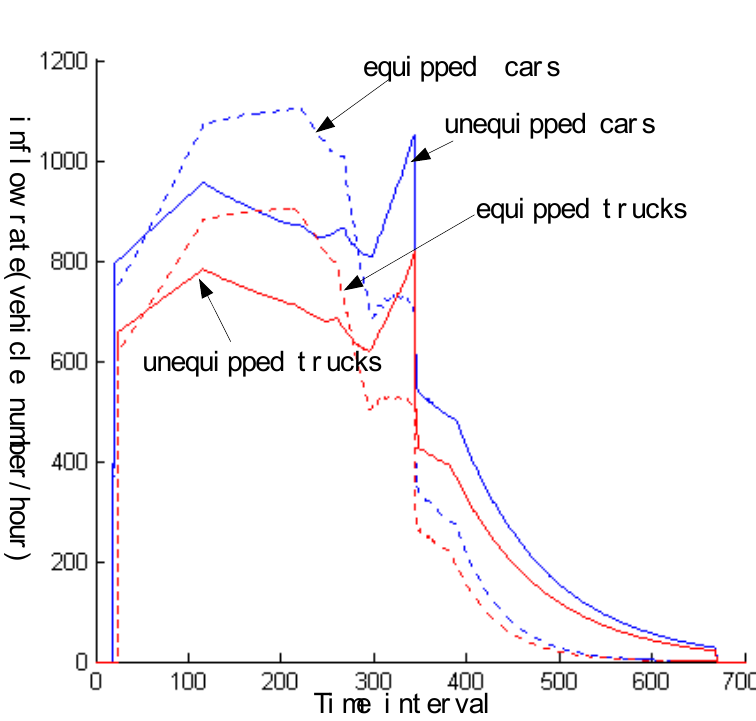
Figure 7. Link 3’s inflow rate of truck and